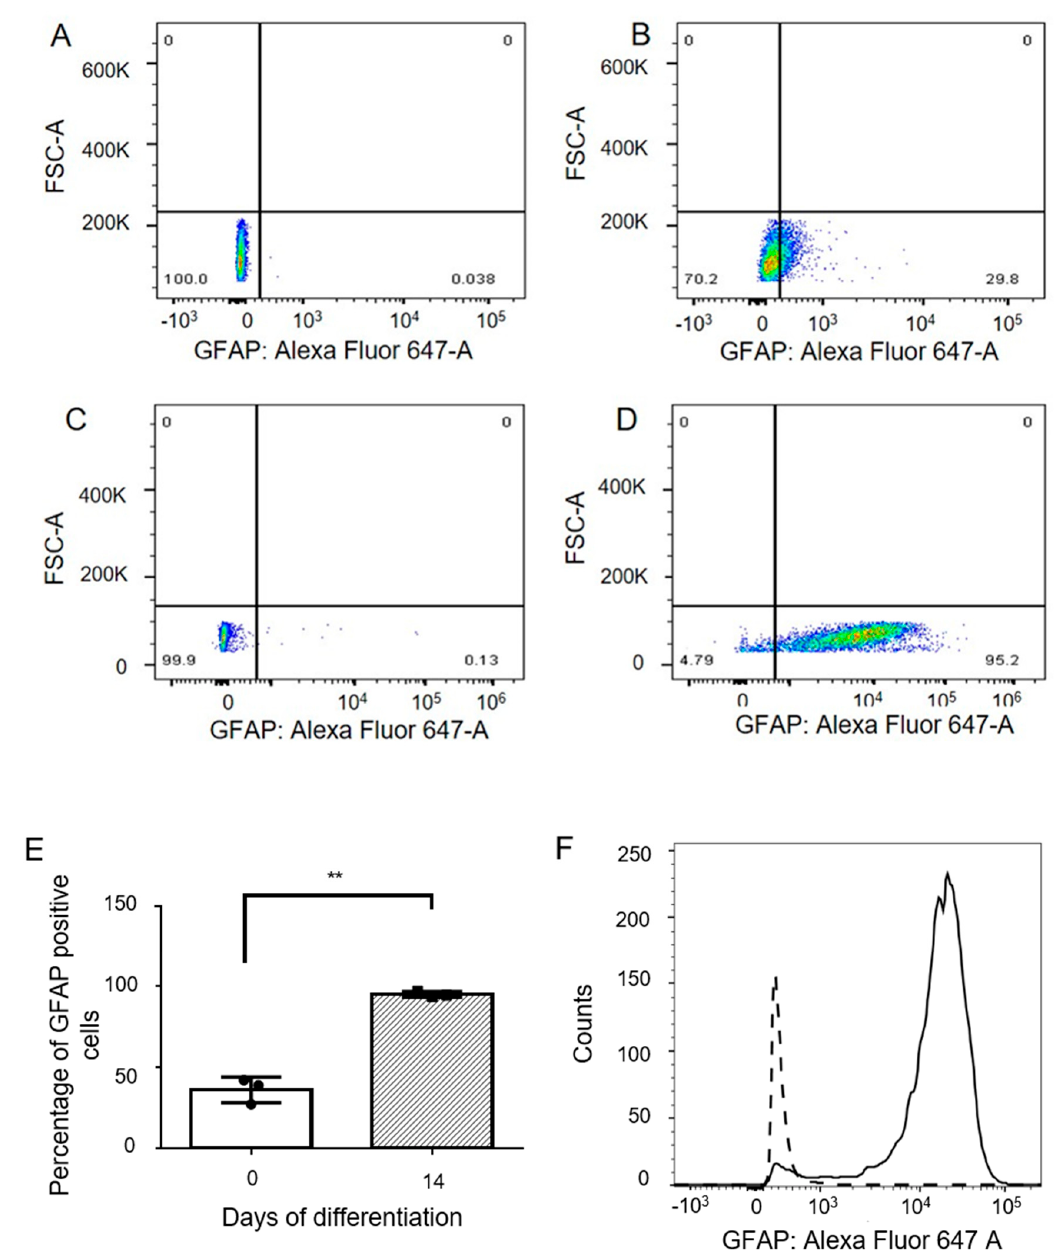
Figure 3. Flow cytometric analysis of GFAP expression during astrocytic differentiation. Dot plots showing ( A ) Unstained and ( B ) stained populations of human FNSCs (day 0). Representative dot plots for ( C )unstained and ( D ) stained populations of cells at day 14 of astrocytic differentiation. ( E ) Quantification of flow cytometric analysis of GFAP expression in differentiating cells (n = 3). ( F ) Representative histogram showing increase in GFAP expression at day 14 compared to day 0 of differentiation. Data represented as Mean ± SD. ** p -value < 0.01.